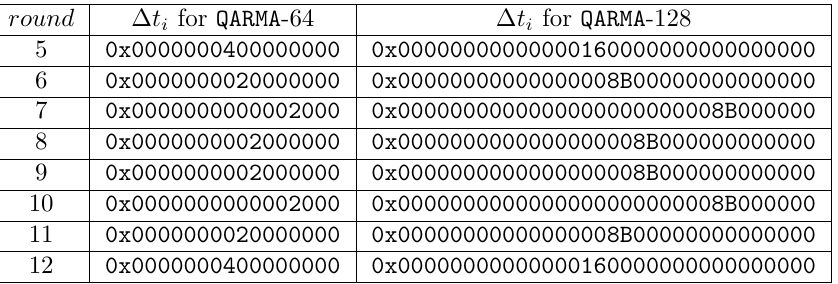
Table 11: Difference of Round Tweak for No. 6 Distinguisher